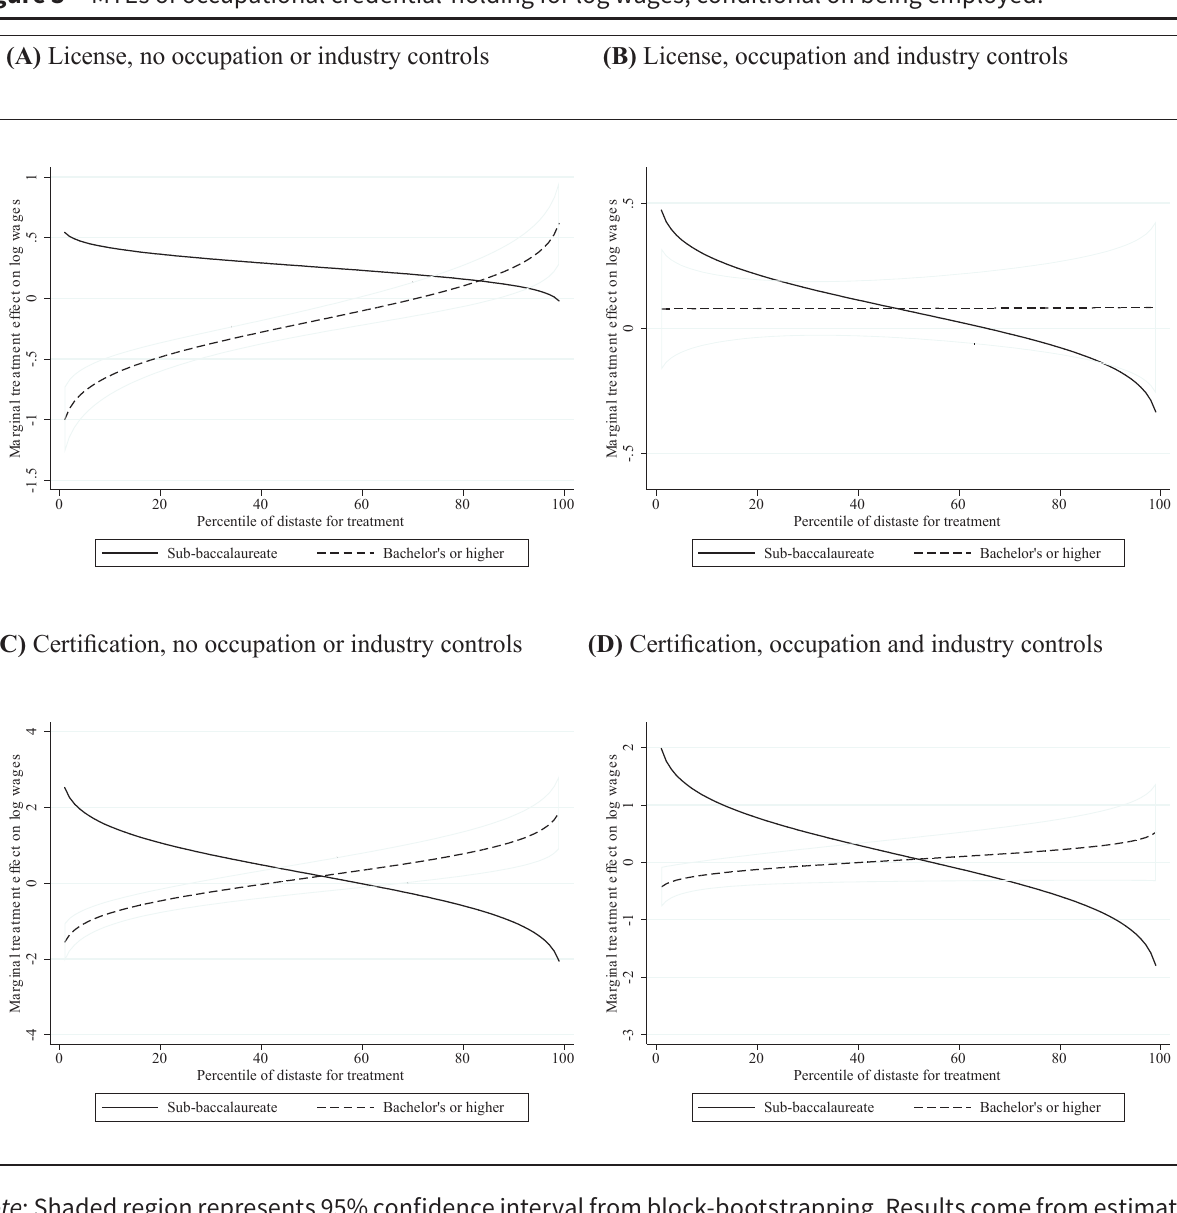
Note : Shaded region represents 95% confidence interval from block-bootstrapping. Results come from estimating MTE model of the marginal impact of credentialing across distaste for treatment on the outcome of probability of being employed. MTEs, marginal treatment